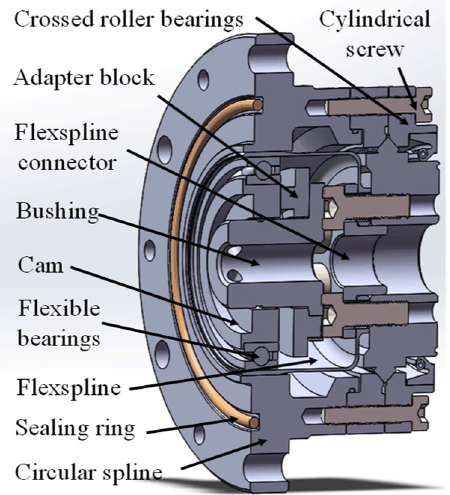
Figure 7: Structure diagram of HD.